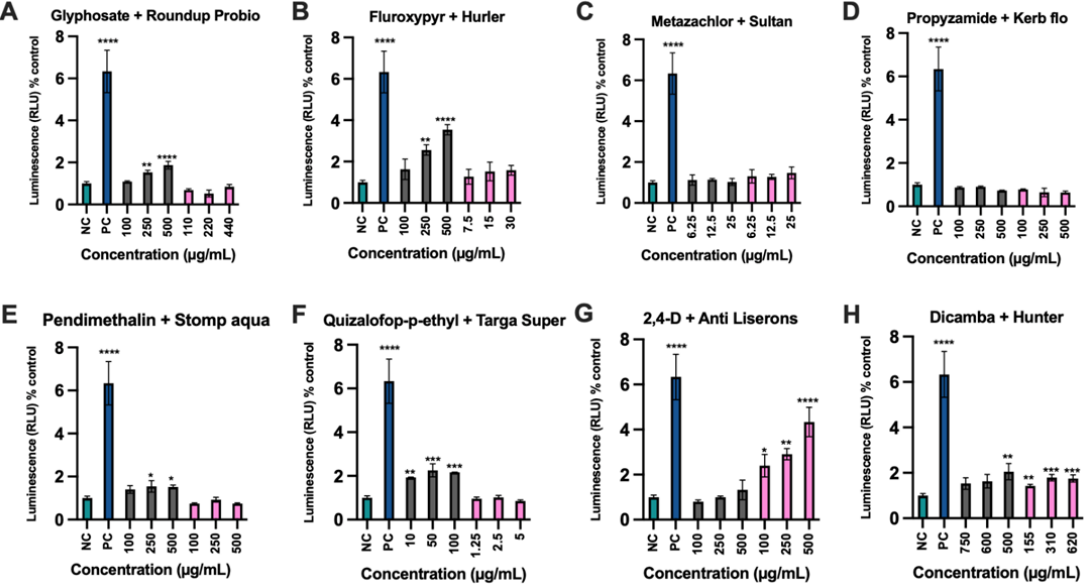
Figure 4. Herbicide-induced oxidative stress in human hepatocyte HepG2 cells. Levels of H 2 O 2 production compared untreated negative control cultures (NC) and positive control (PC) 50 µ M menadione treated cultures with each active ingredient (grey columns) and its respective commercial formulation (pink columns). Results are expressed as relative light units (RLU) from the luciferase reporter ROS-Glo H 2 O 2 detection system. The assay was performed in triplicate and data are expressed as mean ± SD (standard deviation) of 3 independent replicates. * p < 0.05, ** p < 0.01, *** p < 0.001, **** p < 0.0001 in a Man-Whitney test which followed a one-way ANOVA.